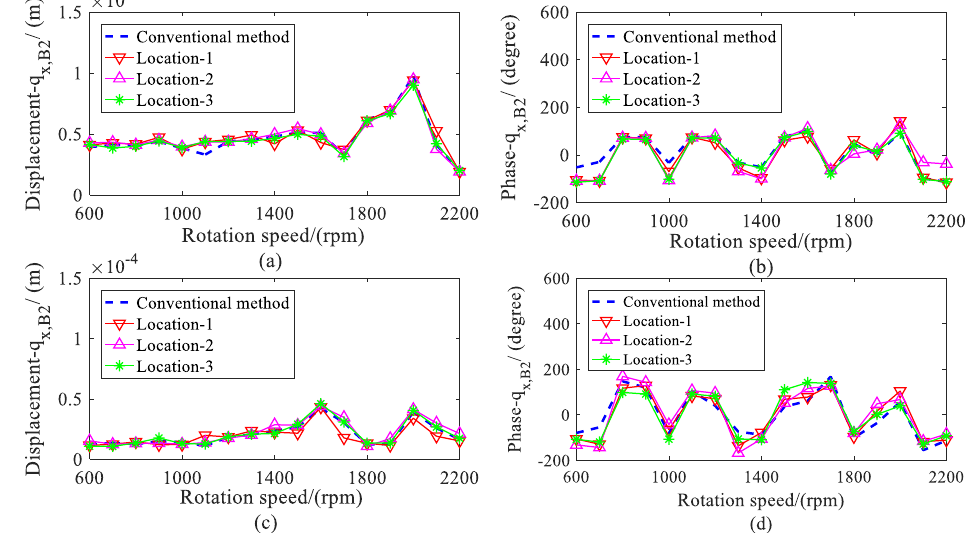
Figure 11. Comparison for displacements of bearing 2. ( a ) amplitude of q x, B 2 ; ( b ) phase of q x, B 2 ; ( c ) amplitude of q y, B 2 ; ( d ) phase of q y, B 2 .